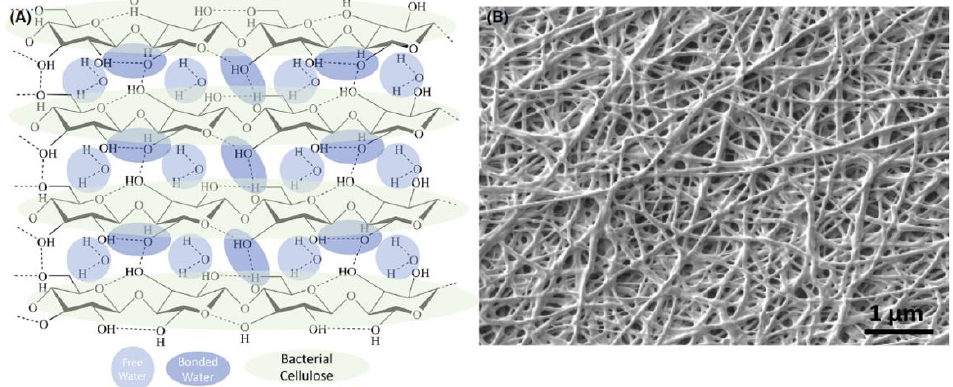
Figure 2. Bacterial cellulose (BC). ( A ) Molecular structure of hydrated BC. ( B ) Typical microscopic BC fiber film morphology [4].